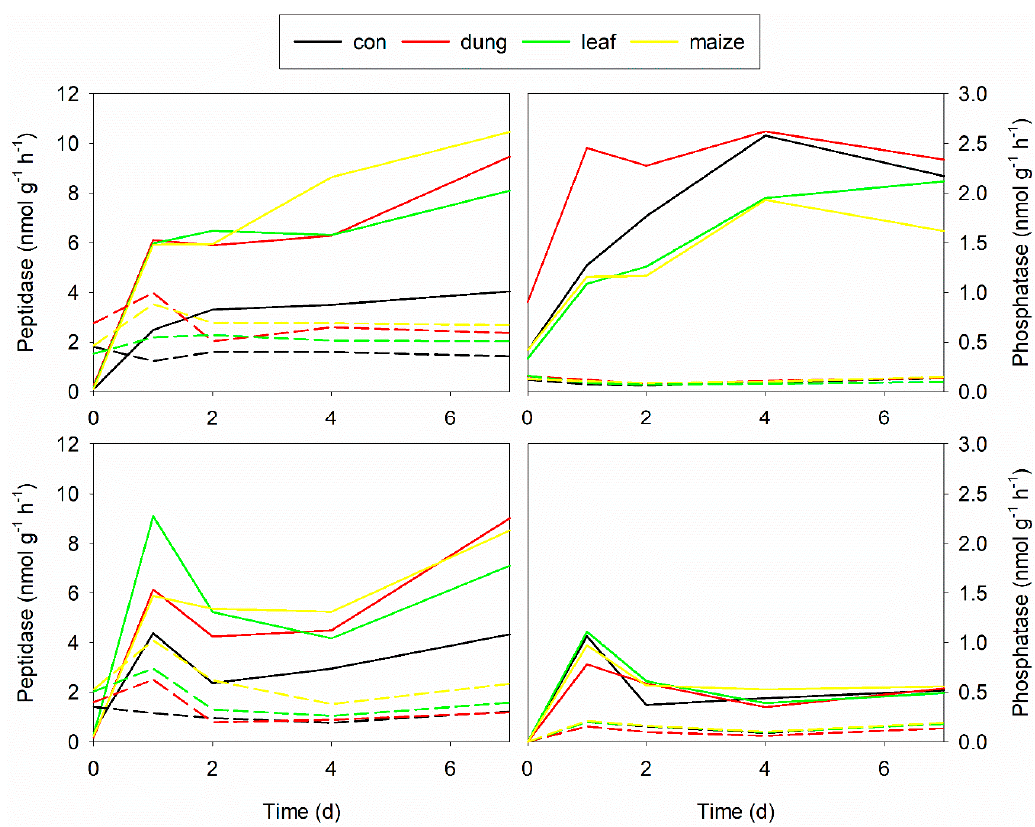
Figure 5. Average changes in the activity of leucine-aminopeptidase and phosphatase in epipsammic biofilms under light (solid lines) and dark (dotted lines) conditions (upper graph = run 1; lower graph = run 2; n = 6).